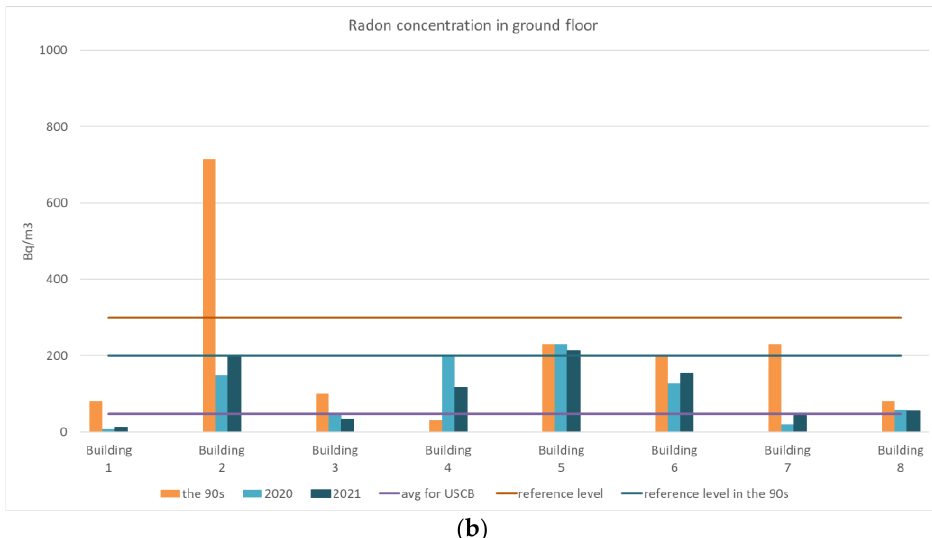
Figure 4. Radon concentrations, measured in the ( a ) basements and ( b ) on the ground floors of the same buildings in the 1990s and in the years 2020 – 2021.